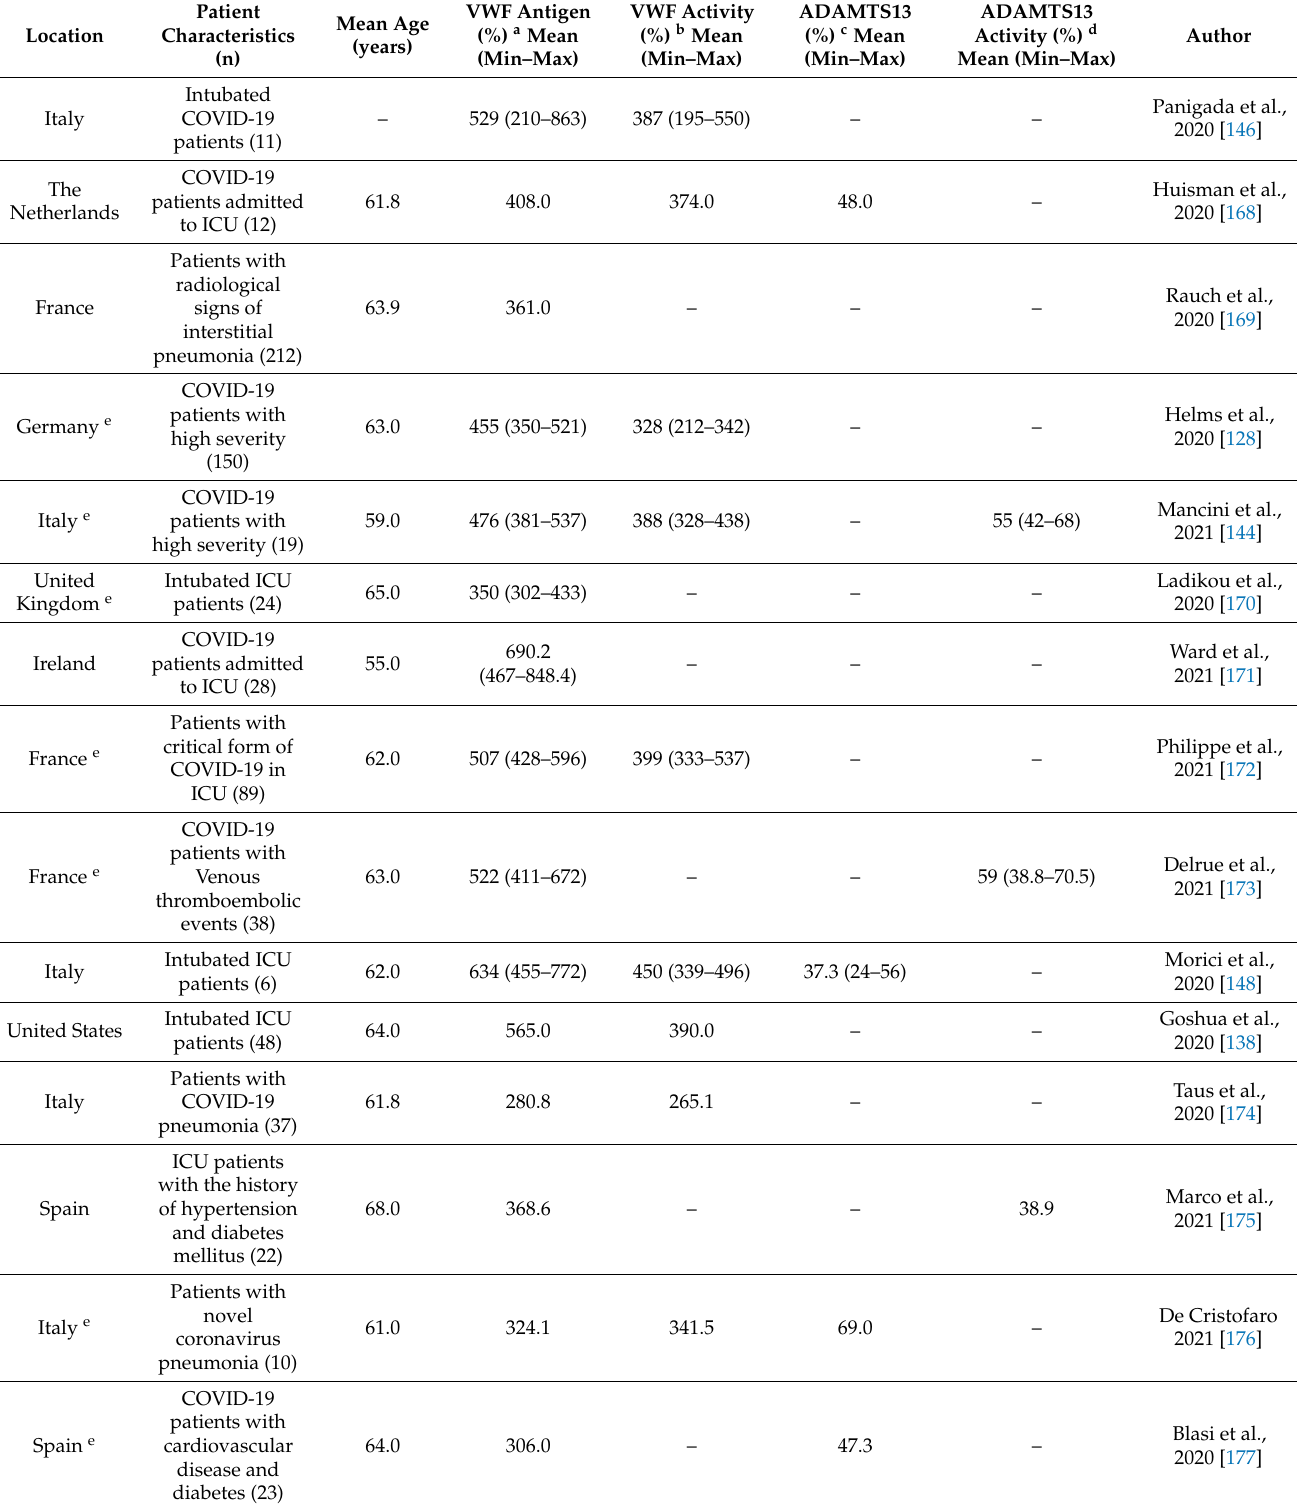
Table 2. VWF and ATDAMTS13 levels ad activity reported in critically ill COVID-19 patients with and without preexisting comorbidities. Normal reference VWF antigen range (%) 42–136 a . Normal reference VWF activity range (%) 42–168 b . Normal ADAMTS13 antigen reference range (%) 40–130 c . Normal ADAMTS13 activity reference range (%) 50–150 d . The value is reported as median (interquartile range) e